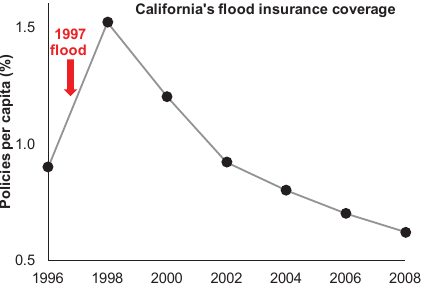
Figure 4. Changing memory and preparedness. Flood insurance coverage in California, which peaked after the 1997 Central Valley flood and then decayed over time (data from Hanak, 2011). Note that in the same period policies per capita in the entire USA were essentially stable (Hanak,